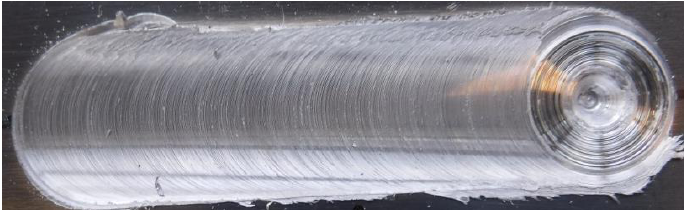
Figure 4. Sample 994.